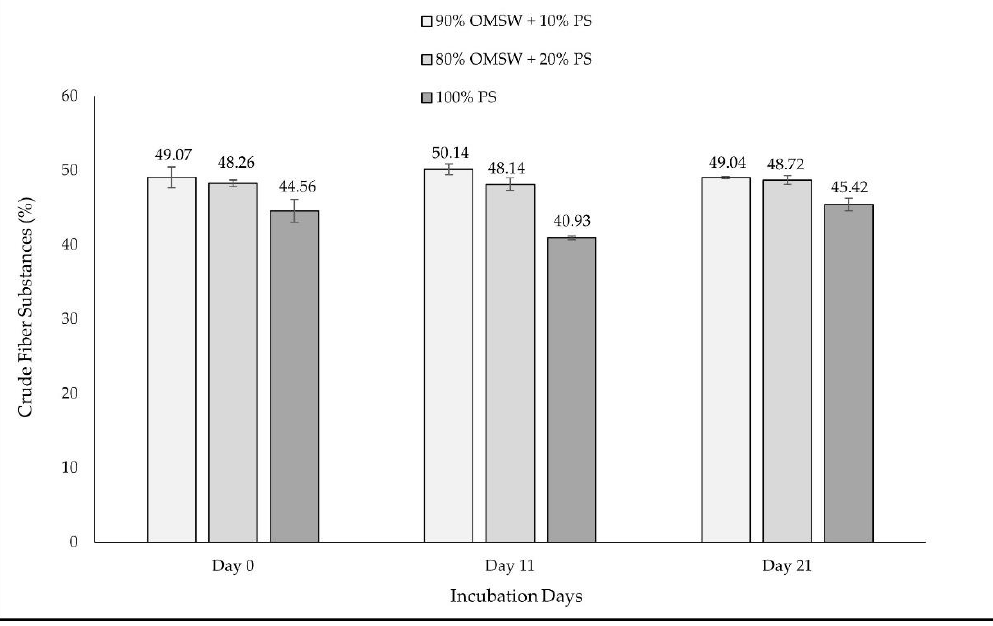
Figure 4. Assessment of Crude Fiber Substances content for PS and its mixtures with OMSW. Statistical analysis was performed for each substrate individually between Day 0 and Day 21.